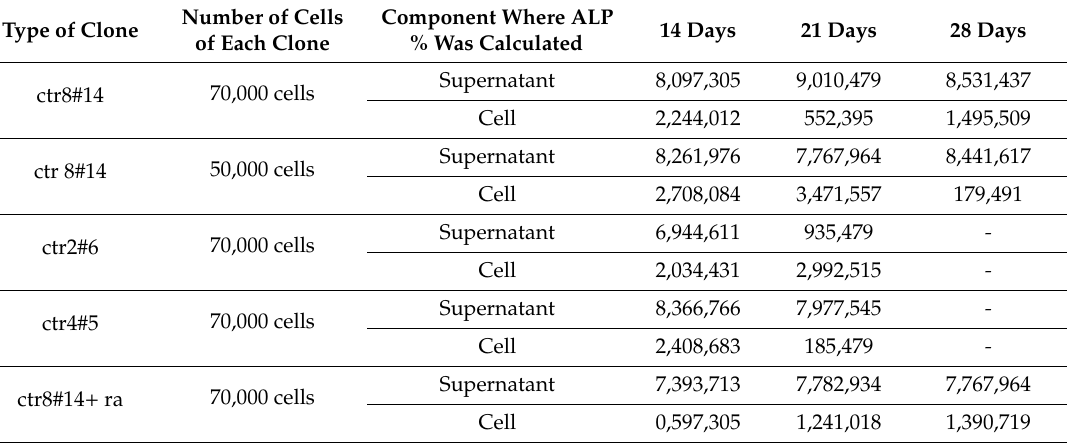
Table 2. This table shows the values obtained from a percentage of alkaline phosphatase (ALP %) obtained with an average of the values at the various observation times (14, 21 and 28